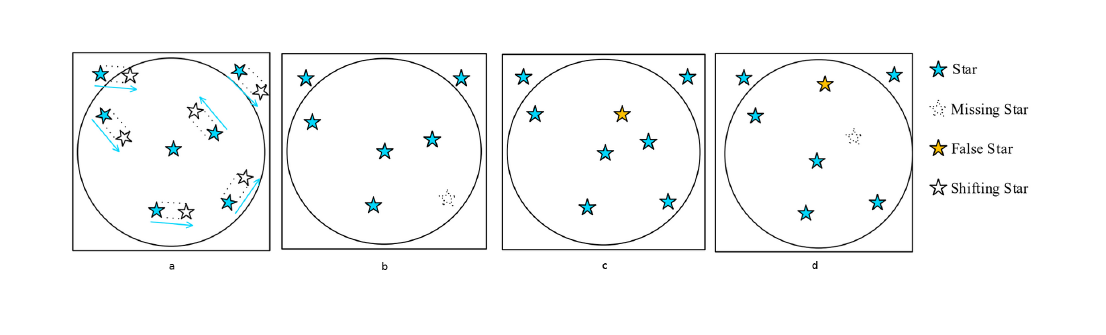
Figure 3. Star identification noise factors. ( a ) star shift; ( b ) dropped star; ( c ) false star; ( d ) combination of noise factors (adapted from